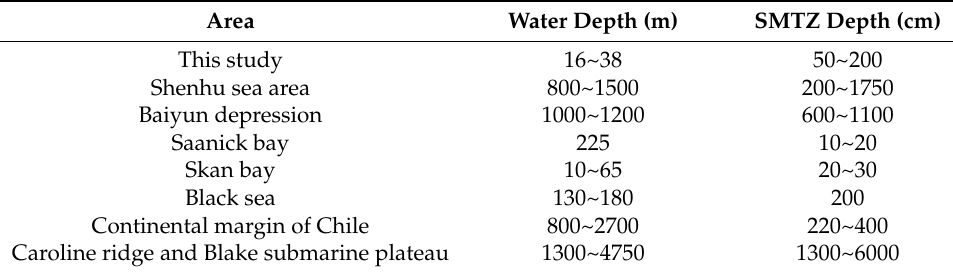
Table 4. Compared SMTZ depths of pockmarks in the study area with other areas. Area Water Depth (m) SMTZ Depth (cm) This study 16~38